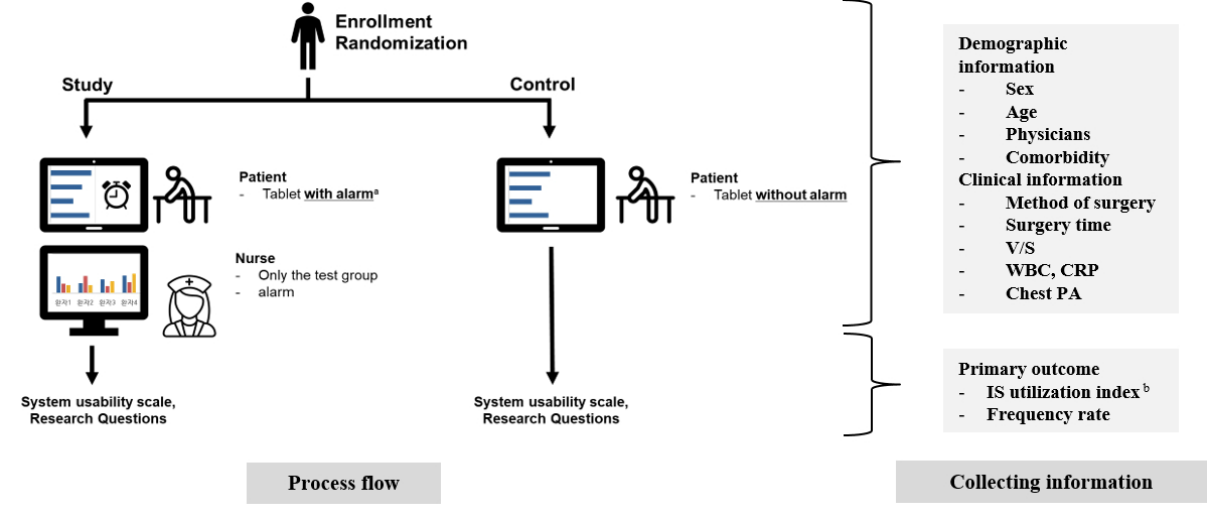
Figure 1. Study protocol. Superscripted "a" indicates alarm every 50 min for insufficient during 9am-9pm (alarm off during 9pm-9am); "b" indicates calculation of performance score applies only to incentive spirometer (full score 240, 10 out of 10 points). V/S: blood pressure, fever, body temperature, respiration rate; CRP: C-reactive protein; IS: incentive spirometer; PA: posterior to anterior; WBC: white blood cell.